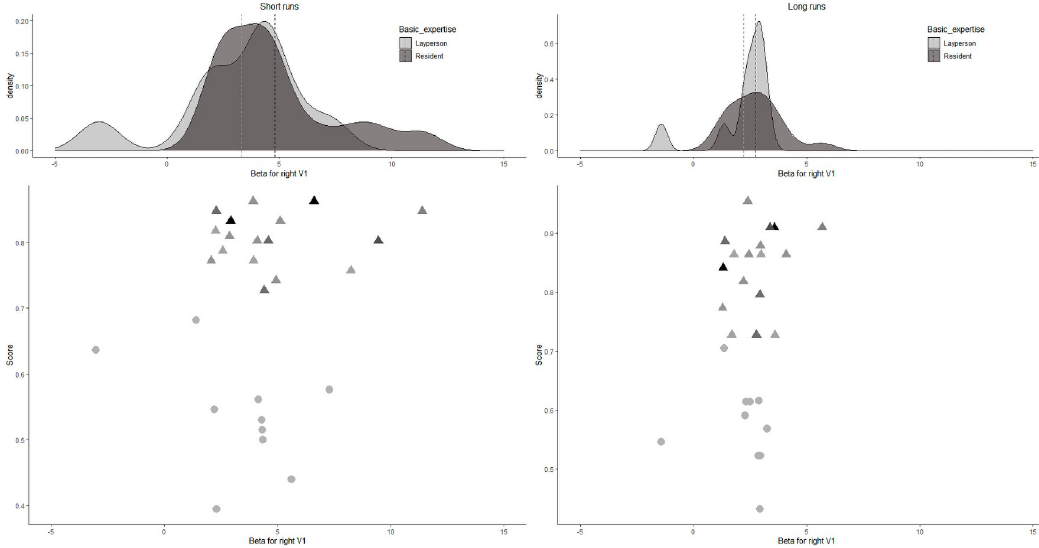
Fig 7. Density plots (upper panels) and scatter plots (lower panels) for the individual beta values in the right V1 for short- and long-presentation trials, for correctly diagnosed trials only. In the upper panels, the dotted line denotes the group mean. In the lower panels, for residents, darker colors depict more experienced